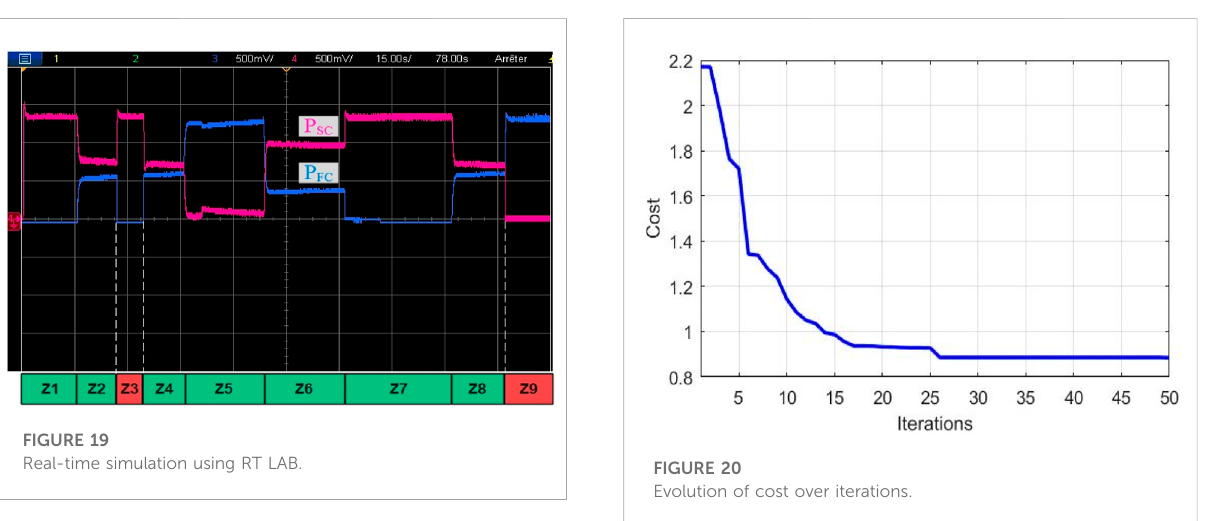
Figure 20, will intervene to isolate the FC and overwrite the power management algorithm by forcing FC power to zero.